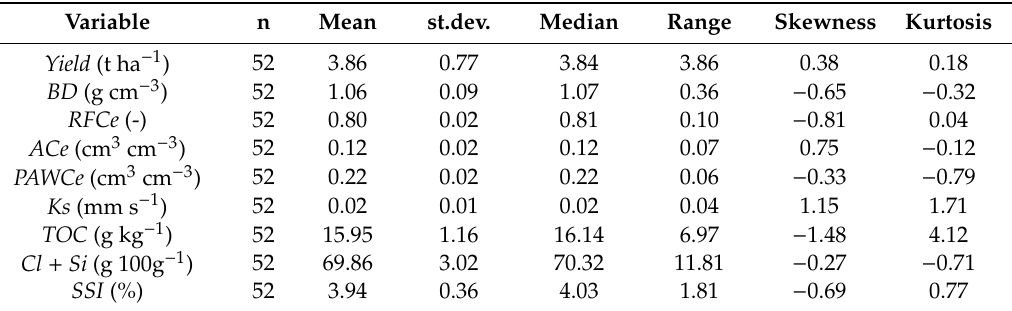
Table 1. Summary statistics for the studied